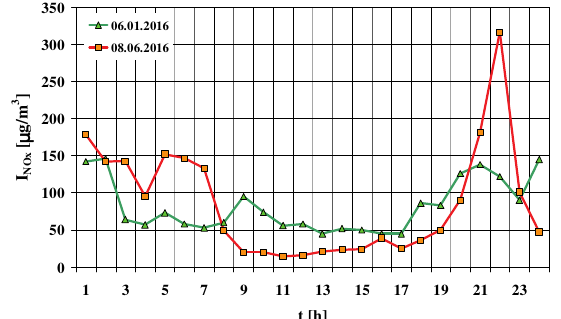
Fig. 15. The immission of nitrogen oxides values obtained from Kraków– Kurdwanów on 6 January 2016 and 8 June